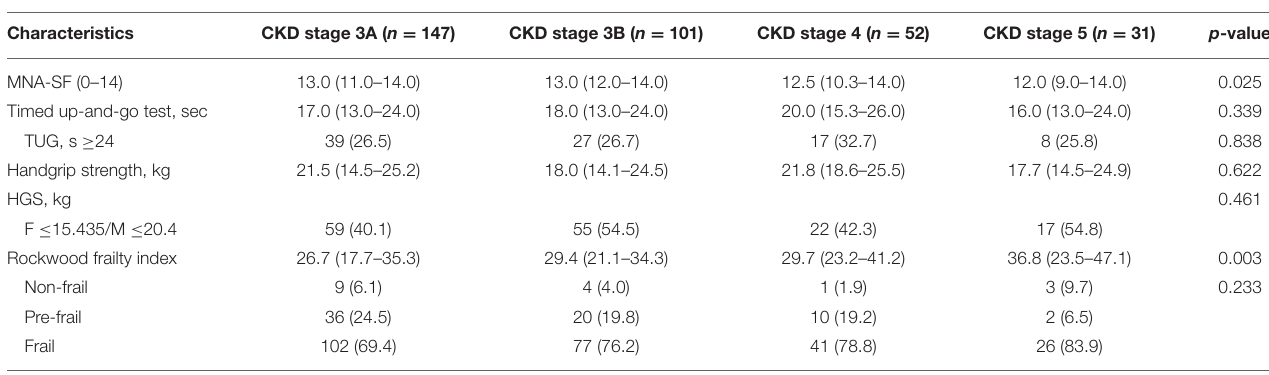
TABLE 2 | Baseline physical functionality in older patients with CKD.